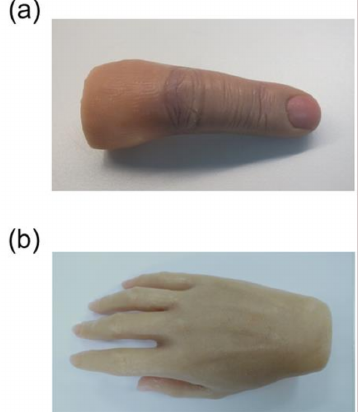
Figure 4. Rehabilitation of finger and hand defects using silicone prostheses: ( a ) finger prosthesis and ( b ) hand